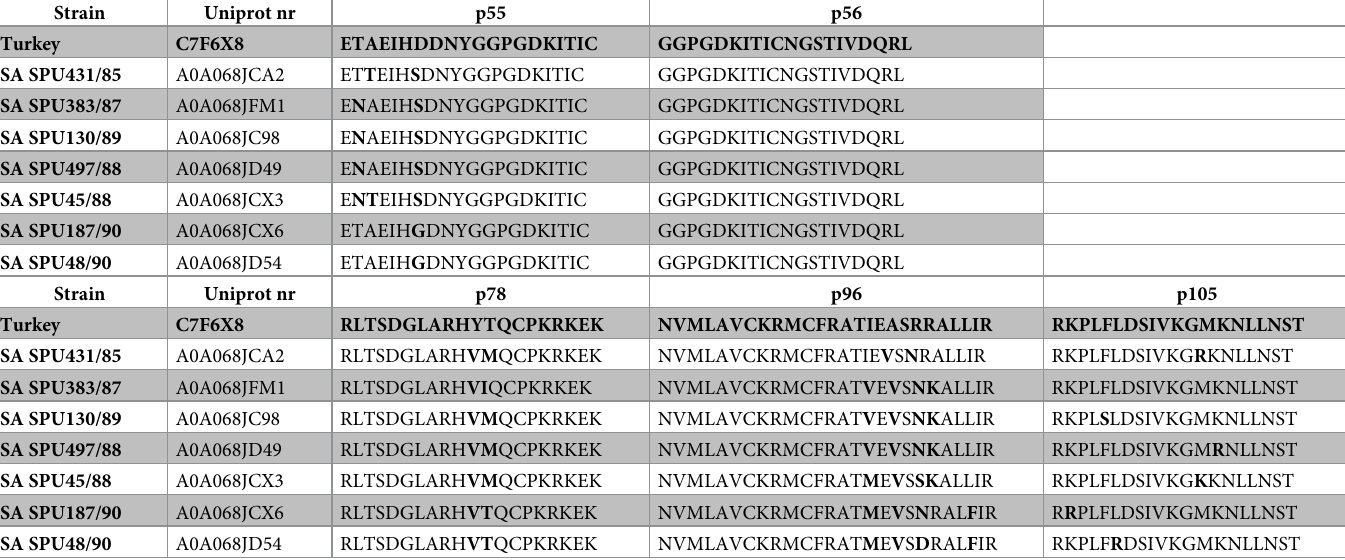
Table 3. Strain similarity, comparison of amino acid sequences from eight strains of CCHFV from South Africa and one strain of CCHFV from Turkey. Sequence data was retrieved from UniProt. Amino acid differences are bolded.